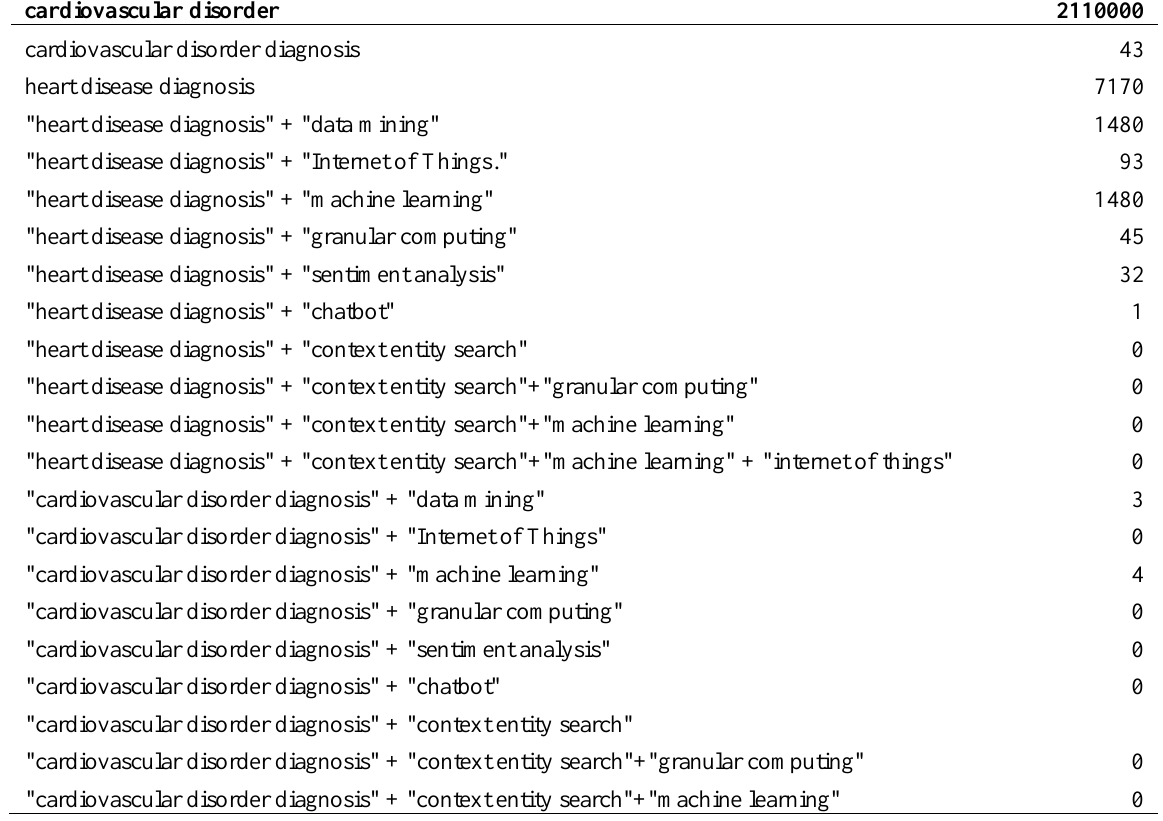
Table 1: Publication Trend of Cardiovascular disorders related articles cardiovascular